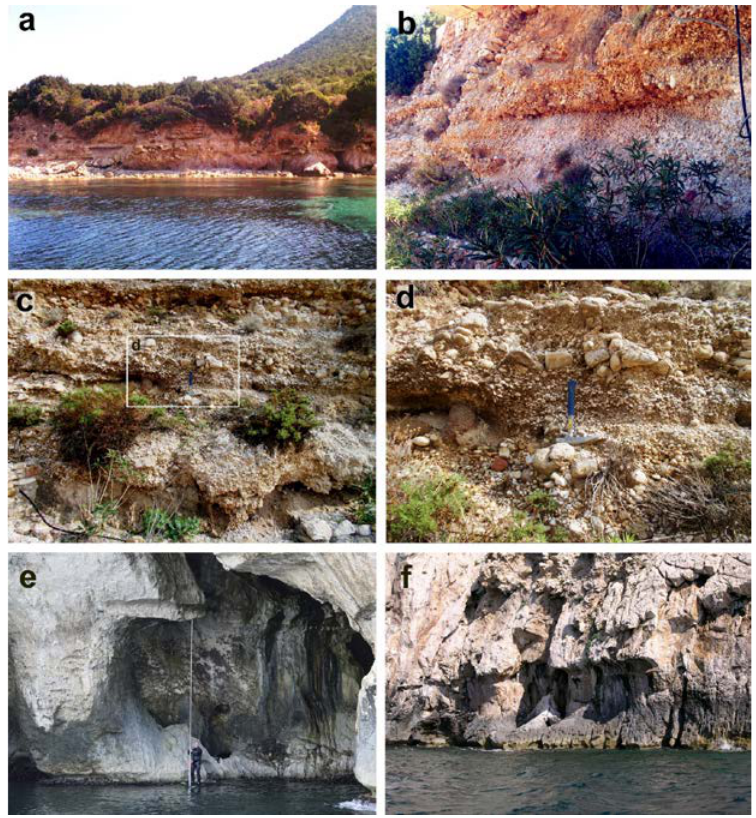
Figure 11. ( a ) A view of the section of Spalmatore Bay marine interglacial fossiliferous sediments transgressive on the granite substrate, Section 1 [8,38,39]; ( b ) conglomeratic heterometric and poly- genic fossiliferous level at the bottom weakly cemented sandstones in parallel-plane lamination; ( c ) section of Punta La Mandria (Section 2) heterometric conglomerate in an arenaceous matrix with a high fossil content resting on a surface of irregular erosion engraved in the dolomitic limestones of Punta La Mandria; ( d ) detail of the previous image, of the conglomerates and micro-conglomerates containing the remains of gastropods ( Patella ferruginea, Verithium vulgatum; Cipraea lurida ) e lamel- libranchi ( Spondilus gaederopus; Mitililus galloprovincialis, Arca noae; Venus verrucosa ); ( e ) tidal notch at +7.5 m in the northeastern sector of the Island of Tavolara, Grotta del Papa, altitude measurement through a precision telescopic staff; ( f ) tidal notch (2) at +7.3 m in the eastern sector of the Island of Tavolara. Part of the continental deposit can be seen at the base, aeolian sandstones at the base and on the slope at the top that fossilized the MIS 5 paleo-tidal notch.